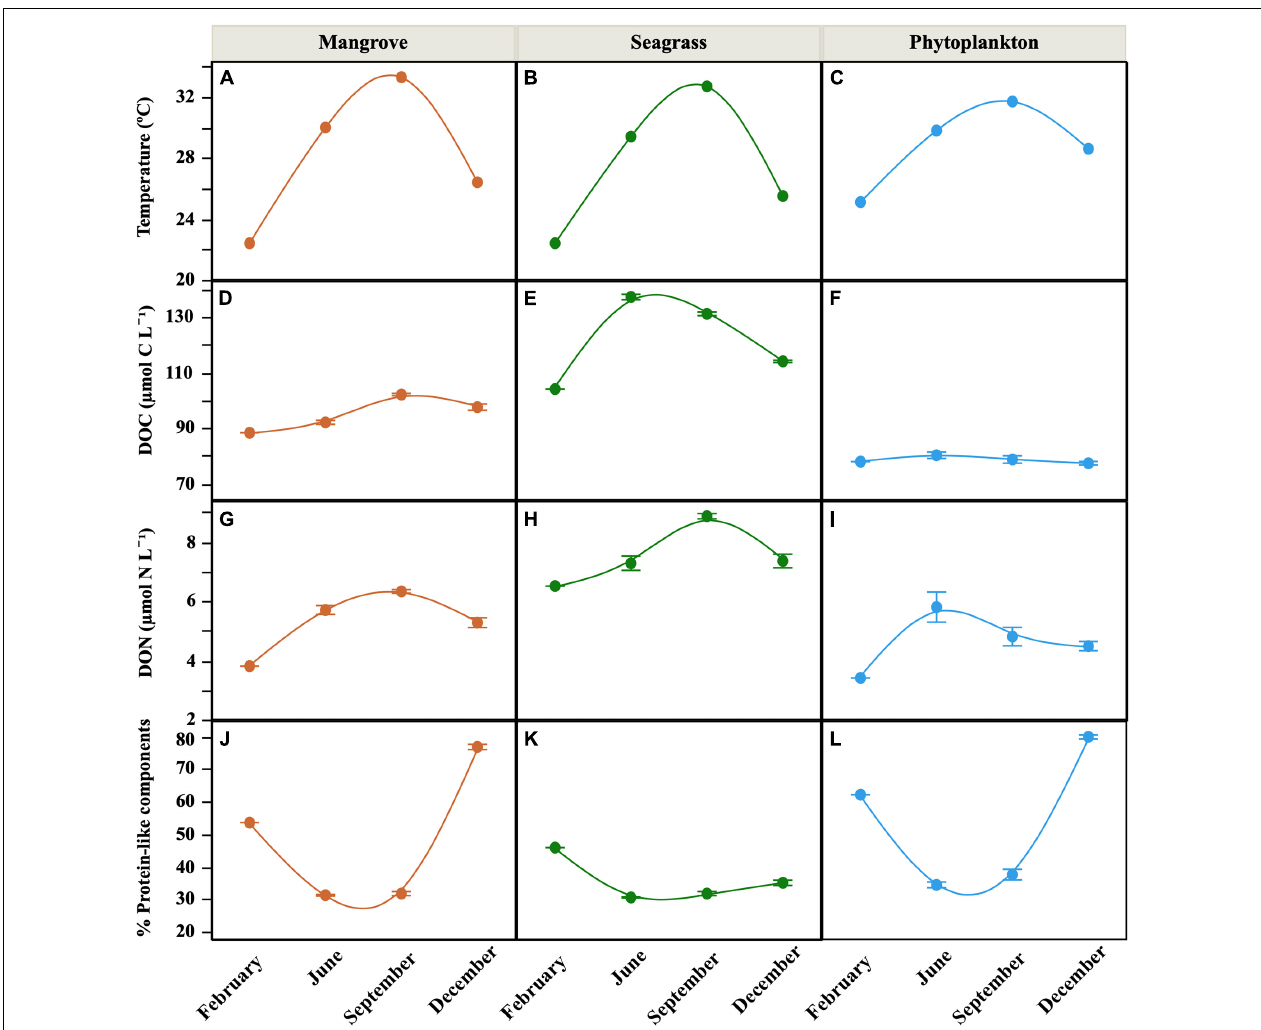
FIGURE 2 | Seasonal distribution of mean ( ± SE) in situ values of temperature (A–C) , DOC concentration (D–F) , DON concentration (G–I), and percent contribution of protein-like components to total FDOM (J–L) at the three sites. Smooth fitting joins site points for clarity.